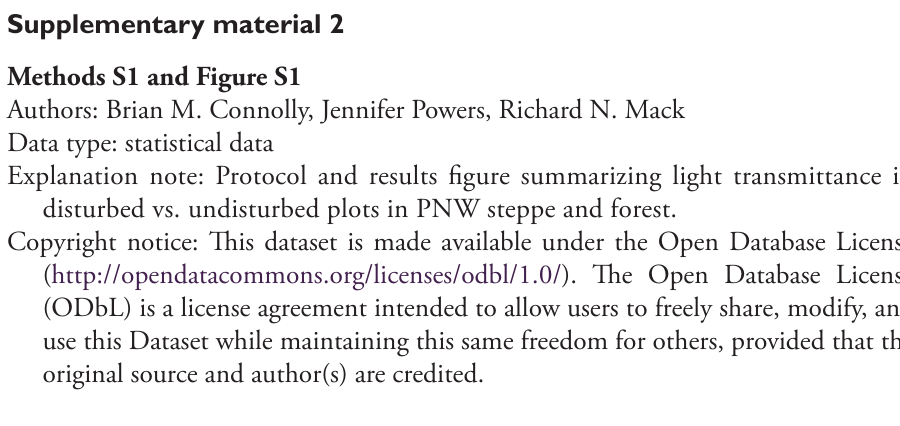
Explanation note: Protocol and results figure summarizing light transmittance in disturbed vs. undisturbed plots in PNW steppe and